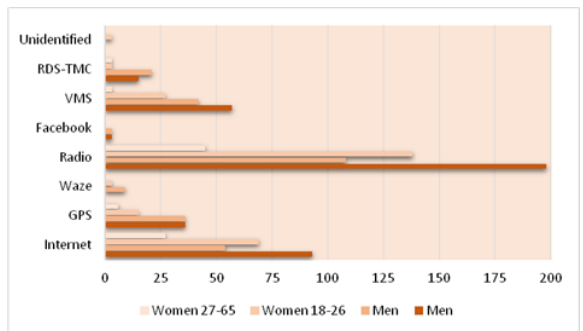
Figure 6. Information systems used and their share in obtaining traffic information.